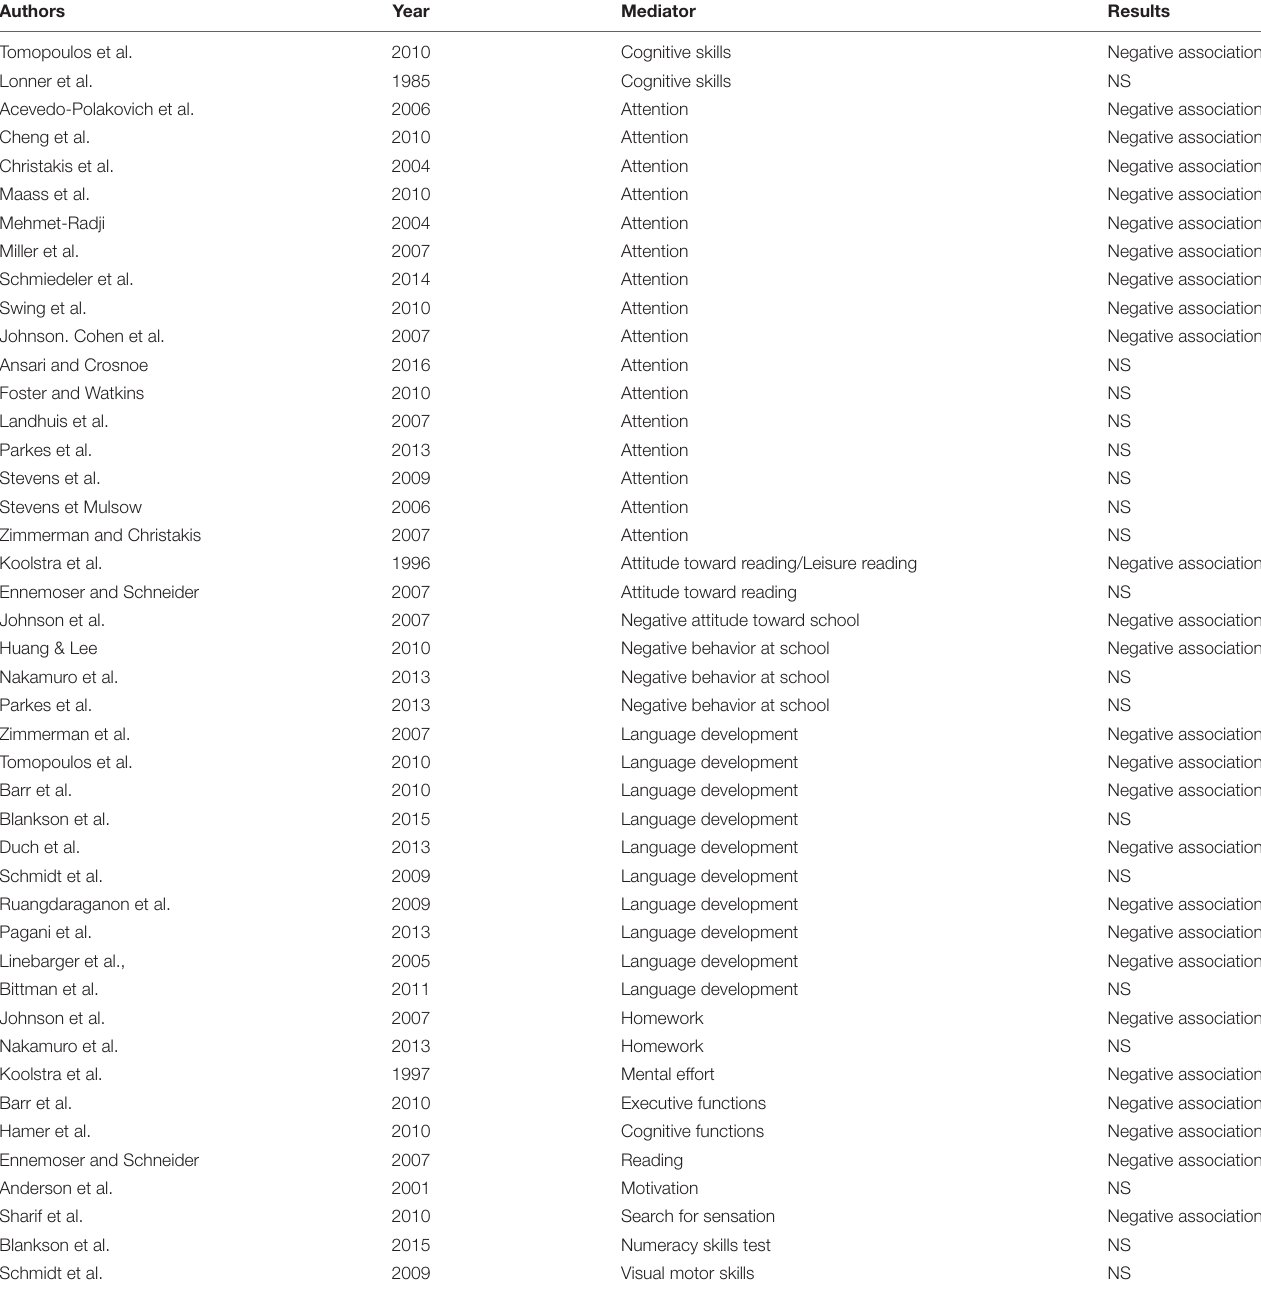
TABLE 1 | Studies on the association between TV viewing time and mediating